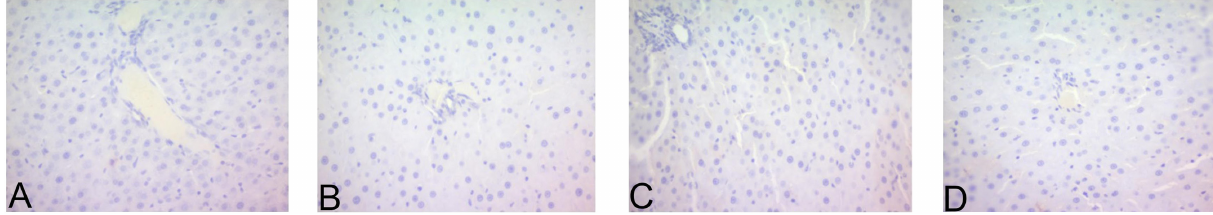
Figure 2. Representative micrographs from group I (A), group II (B), group III (C), and group IV (D) shows 8-hydroxy-2’-deoxyguanosine immune negativity. × 20 immunohistochemical staining.